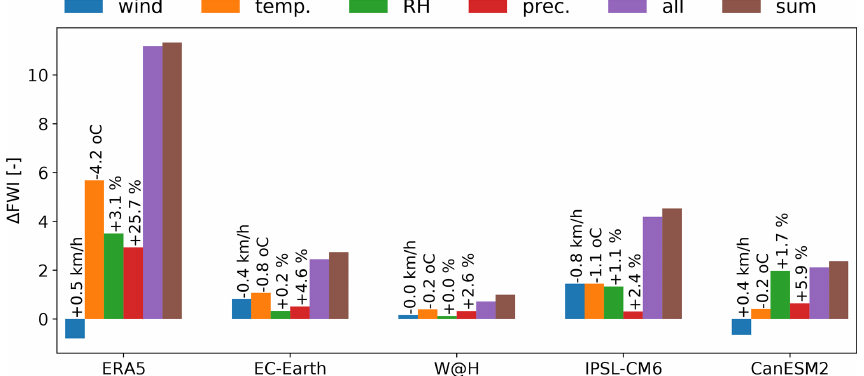
Figure 9. Sensitivity analysis of the FWI7x-SM to changes in individual contributions from relative humidity (RH, wind, temperature and precipitation). The relative increases or decreases for the individual variables of the climate models are based on the average change in input variables between the climate of the present day and the early 20th century (values above bars). For ERA5 the changes are based on a linear regression of the respective variable onto GMST for the years 1979 to 2018 and then extrapolated to the early 20th century. These changes are subtracted from the 2019 ERA5 data, after which the FWI is recomputed, where (cid:49) FWI is the original FWI minus the altered FWI. In the “all” experiment all input variables are changed simultaneously. “Sum” is the sum of all the individual changes in the FWI. W@H: